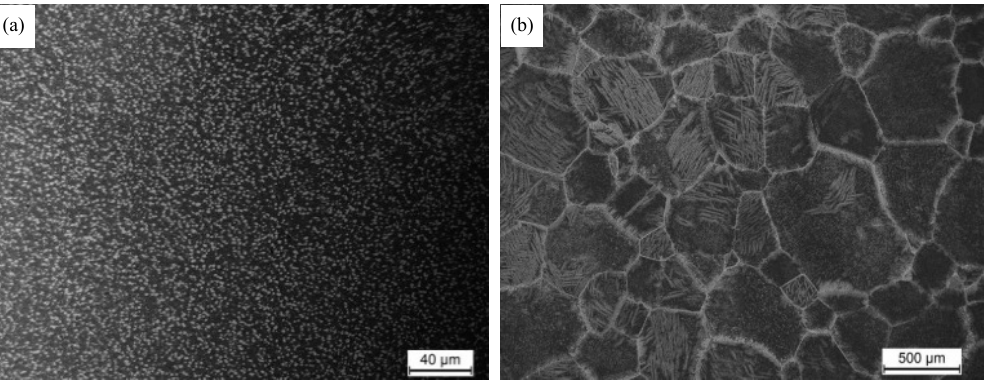
Figure 2. The initial microstructure of the Ti-55531 titanium alloy: ( a ) as-received microstructure, ( b ) after prior β heat treatment.